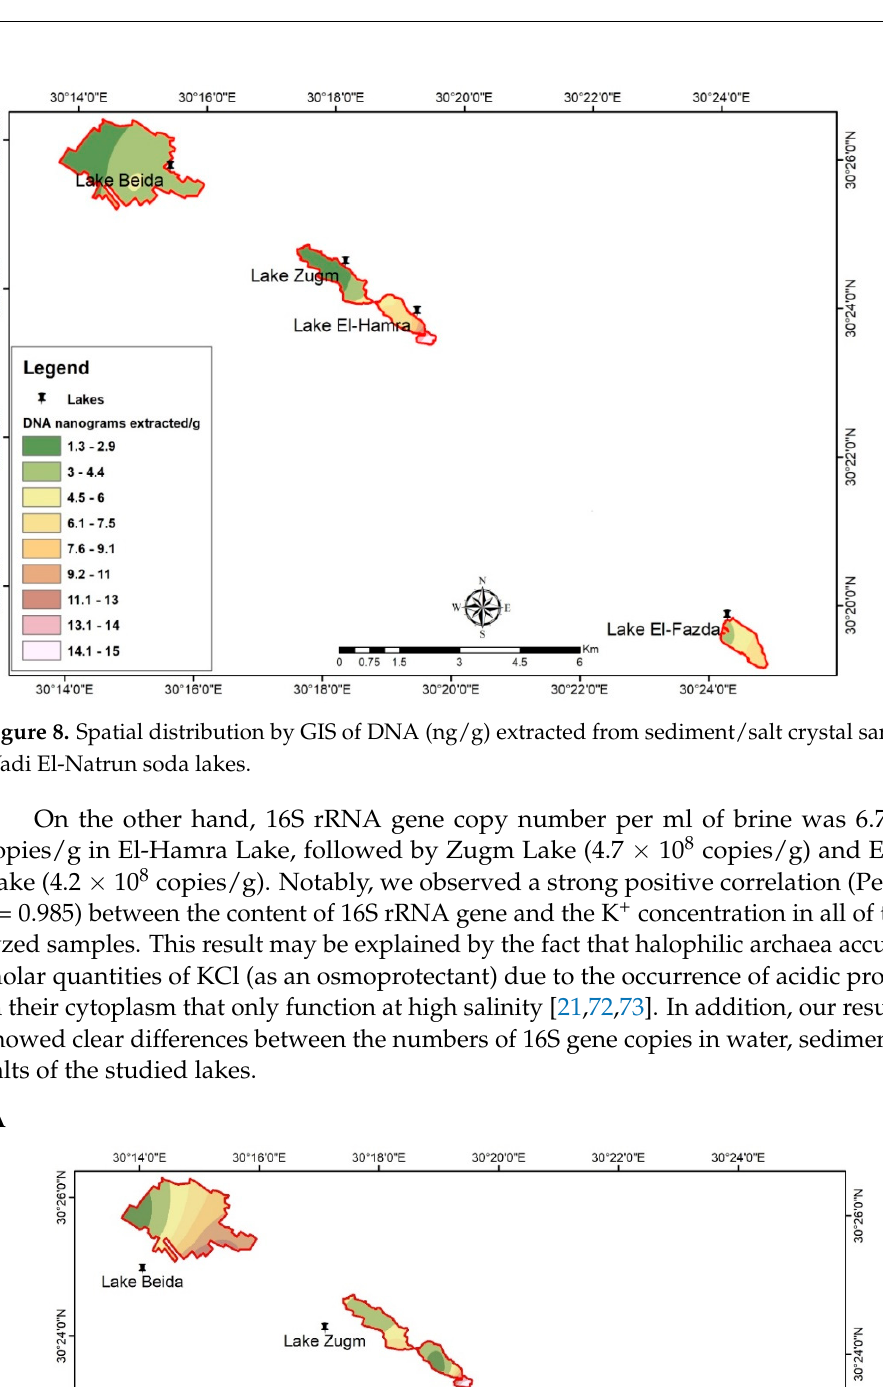
Figure 9. DNA copy number distribution of the archaeal 16S rRNA gene ( A ) per gram of sediment and ( B ) per mL of water from soda lakes of Wadi El-Natrun. 4. Conclusions The distribution of any organism in the environment is restricted to the physico- chemical characteristics of the sampling site. Soda lakes are rare and extreme ecosystems with great potential for bioprospecting aimed at discovering novel enzyme or genes for new biotechnological applications. This report provides a first representation of the ar- chaeal community structure and spatial distribution in four soda lakes located in the Wadi El-Natrun valley (northern Egypt) using 16S rRNA PCR-DGGE fingerprinting and com- bining traditional GIS mapping technology with remote sensing. Using these approaches,